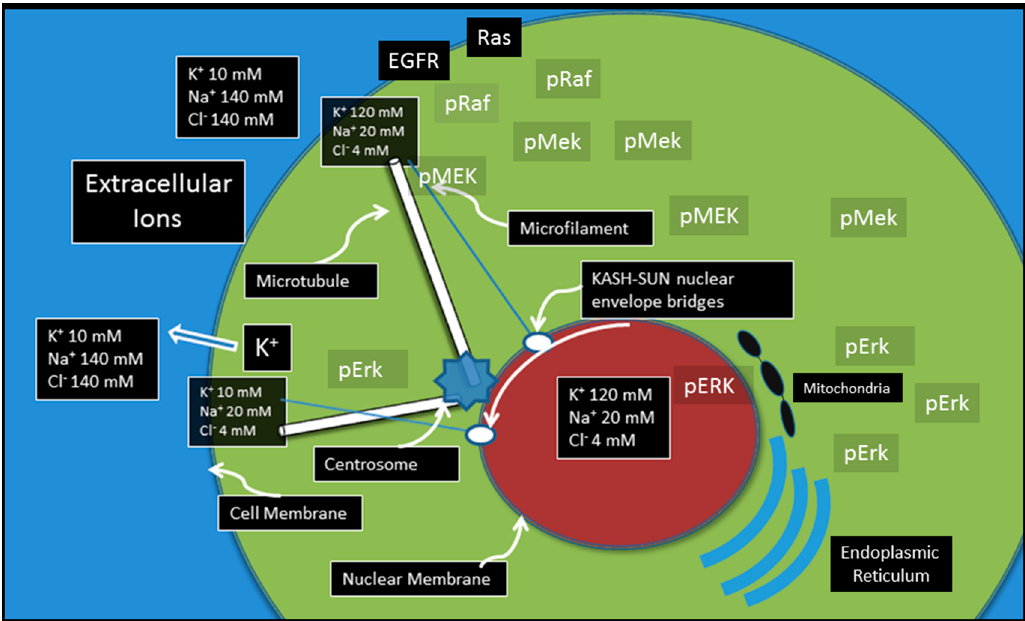
Figure 3. An integrative model of communication from cell membrane receptors to other components of the cell. The canonical molecular pathways are amplifiers that allow signals to reach the nucleus, mitochondria, and endoplasmic reticulum. However, di ff usion in three dimensions results in degradation of spatial and temporal information. The microfilaments and microtubules allow rapid, bi-directional flow ions between the cytoplasm adjacent to the cell membrane and the centrosome (via microtubules) and the nuclear membrane (via microfilaments). This permits rapid communication of both coarse-grained and fine-grained information with minimum information loss. Furthermore, the associated spatial and temporal information may be critical for survival in single-cell organisms and in the organization and function of multicellular tissue.